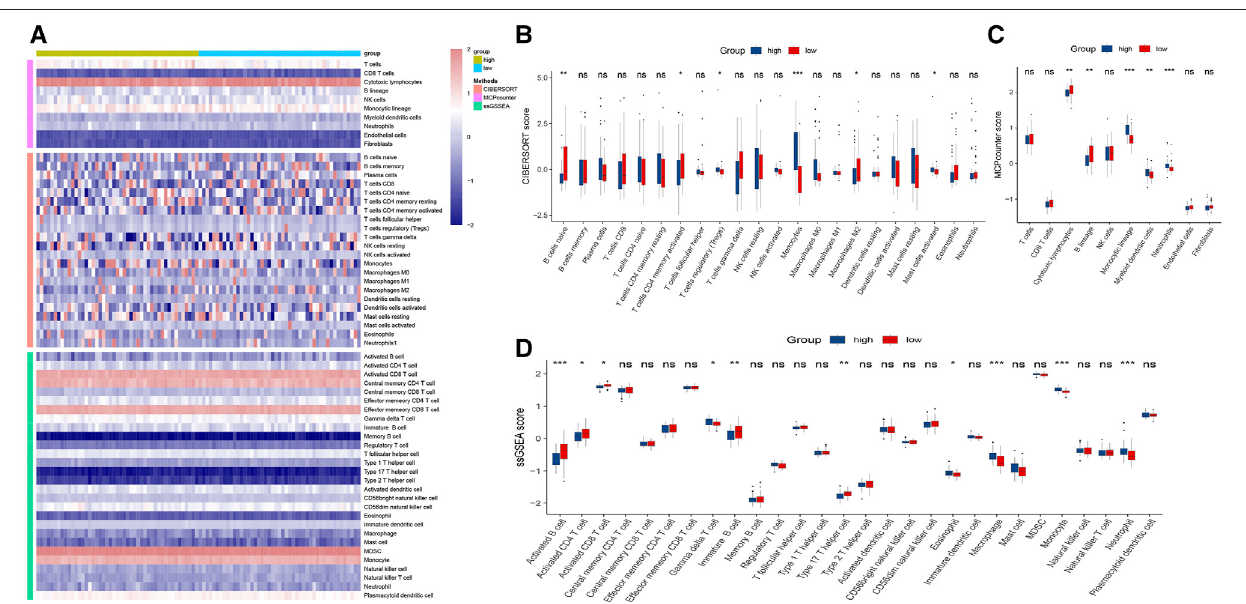
FIGURE 7 | Immune in fi ltration analysis of the high- and low-risk groups. (A) : Heatmap for immune analysis based on CIBERSORT, MCP-counter and ssGSEA algorithmsamongtwosubtypes. (B – D) :ImmunecellsubsetandrelatedfunctionassociationbytheCIBERSORT,MCP-counterandssGSEAalgorithms.* p < 0.05,** p < 0.01, *** p <